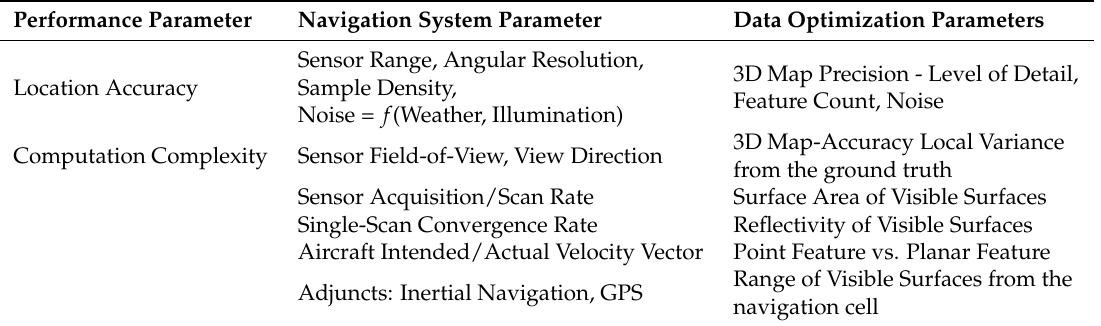
Table 1. Performance